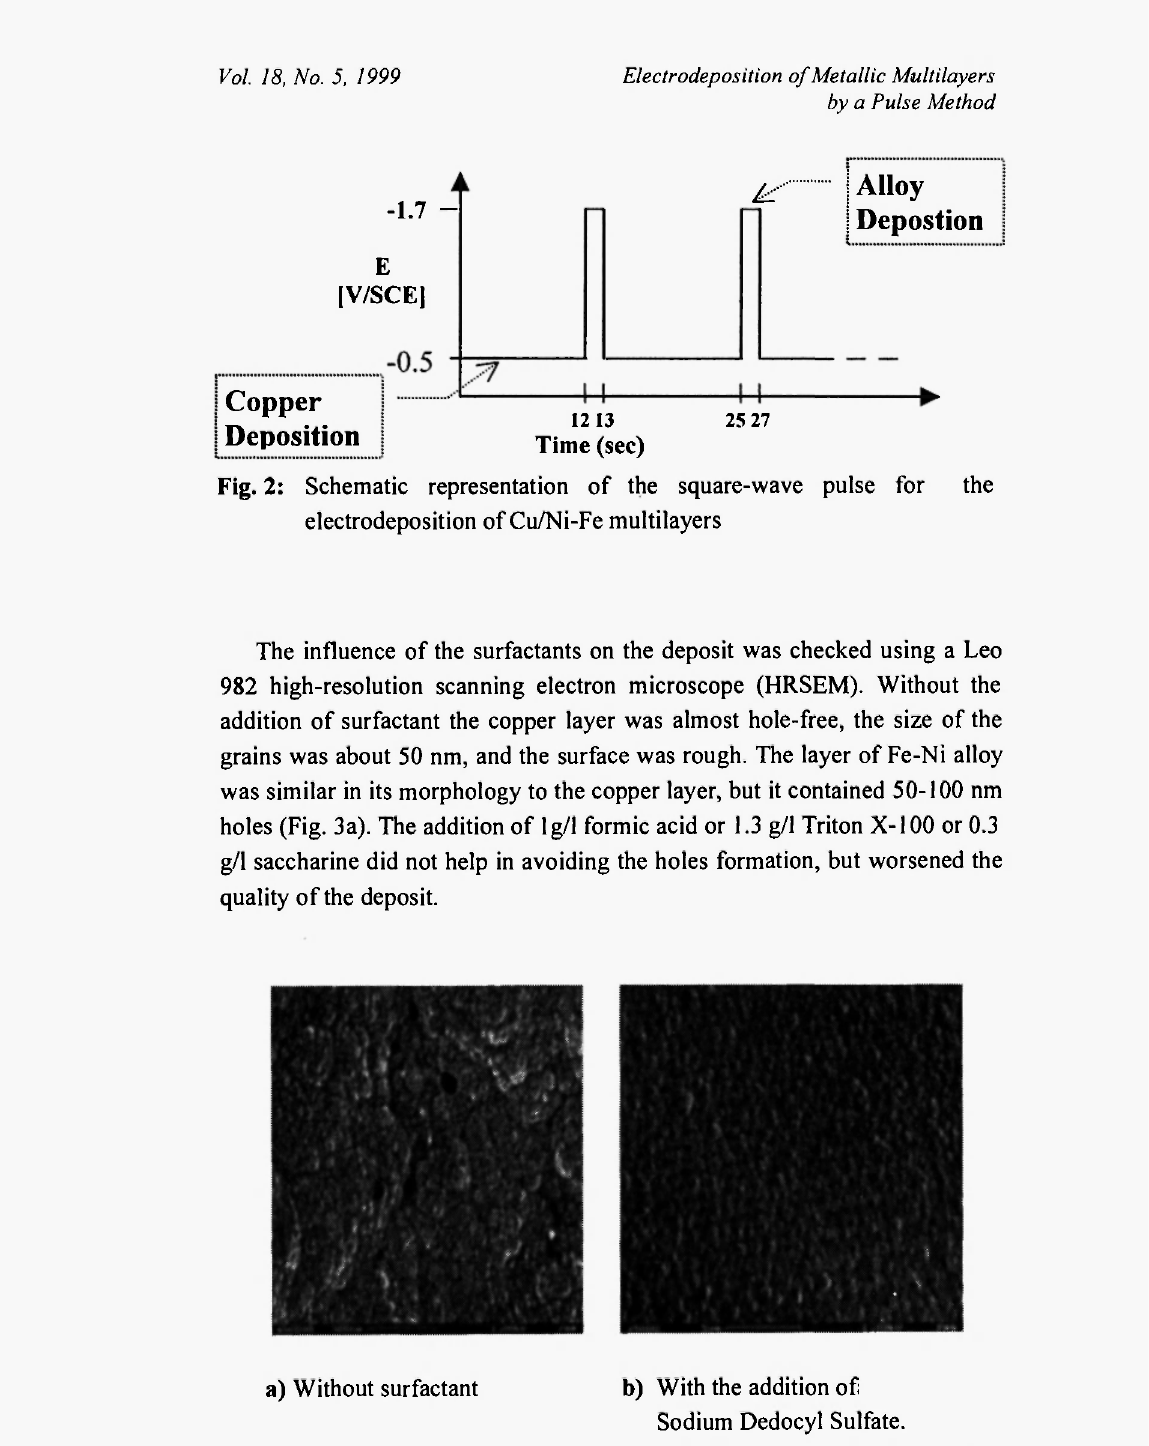
Sodium Dedocyl Fig. 3: HRSEM micrograph of electrodeposited Ni-Fe layer (top view)